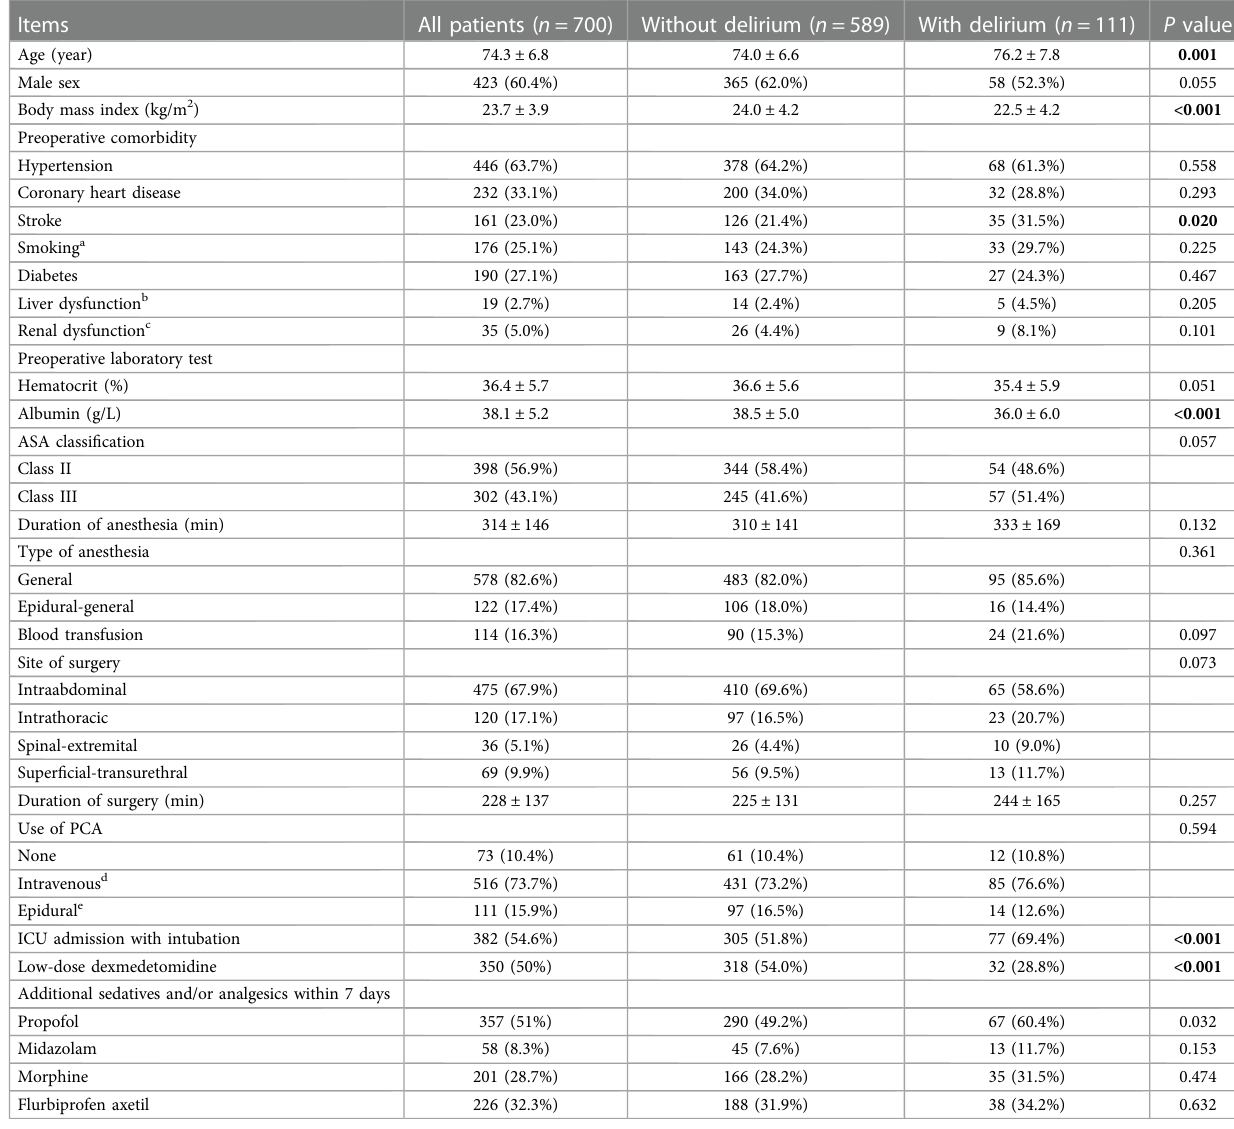
TABLE 1 Baseline and perioperative